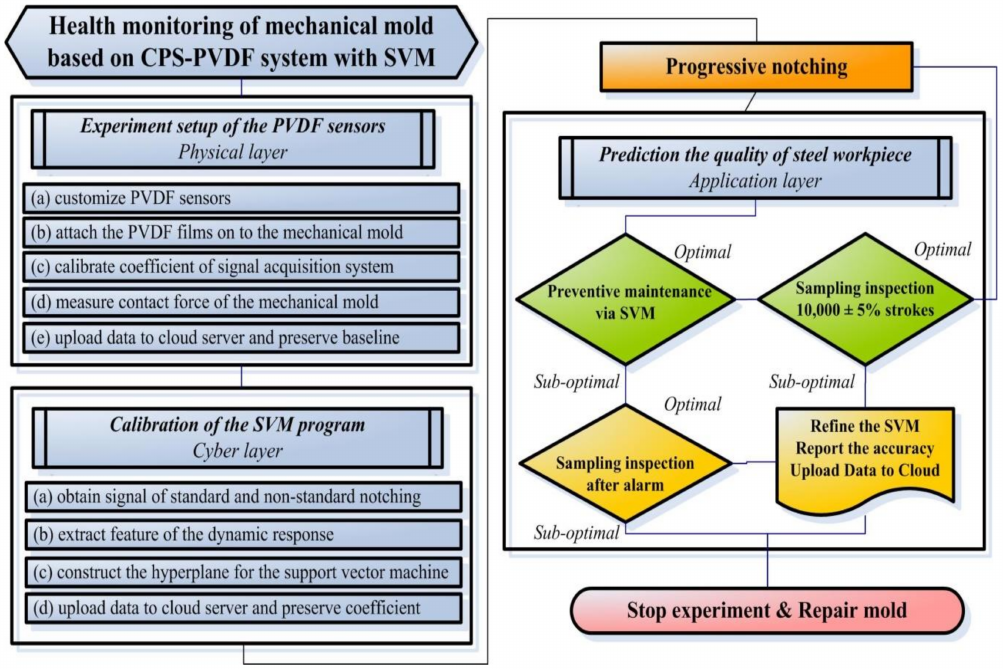
Figure 2. Flow chart of proposed CPS-PVDF system with SVM: customized PVDF sensors obtained direct measurements of contact force and sent dynamic signals with high SNR for interpretation via SVM and predictions pertaining to quality were verified via 3D scanning and surface